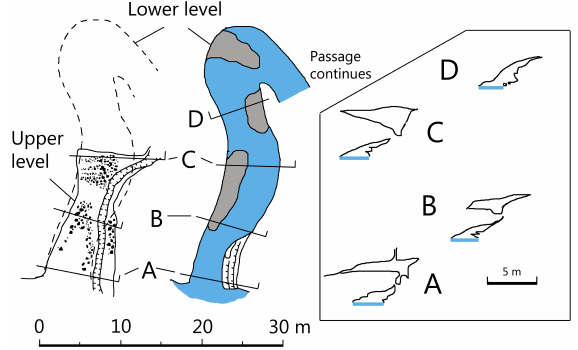
Figure 6. Plan and passage cross sections of conduit NG-05. The plan view of the upper level shows boulders and an incised channel on the conduit floor. For location see Fig.